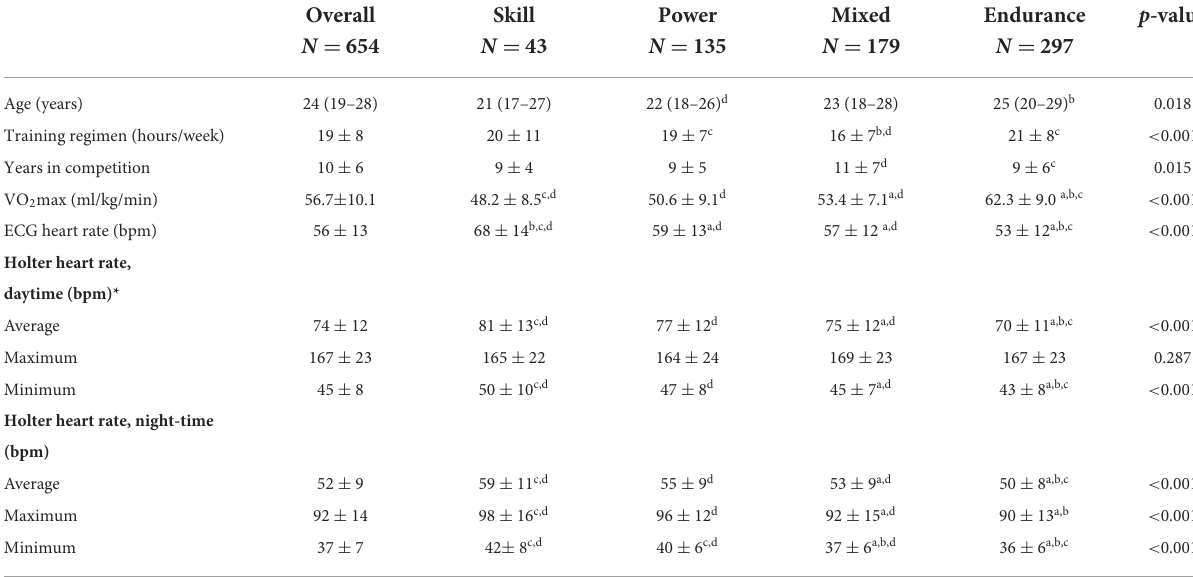
TABLE 1 Demographics and training characteristics of the participants who underwent Holter monitoring.